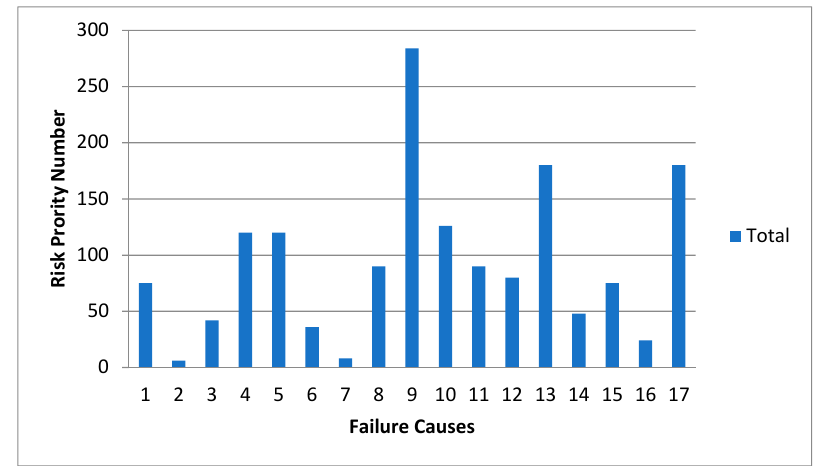
Figure 7. Distribution of failure causes to risk priority number (RPN) for pusher mechanism. Machines 2018 , 6 , x FOR PEER REVIEW